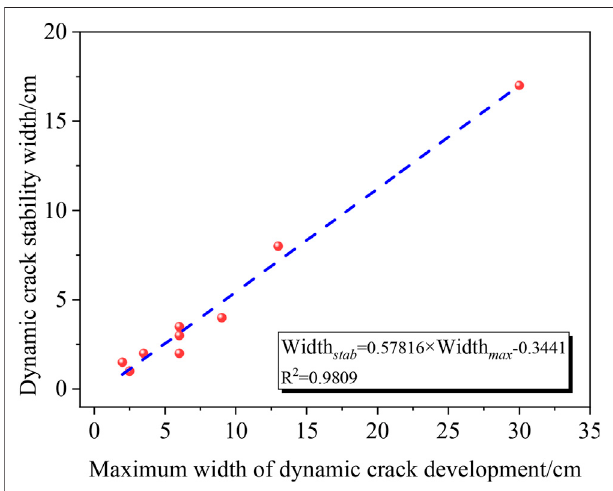
FIGURE 5 | Maximum width of dynamic fi ssure development vs. stable width.